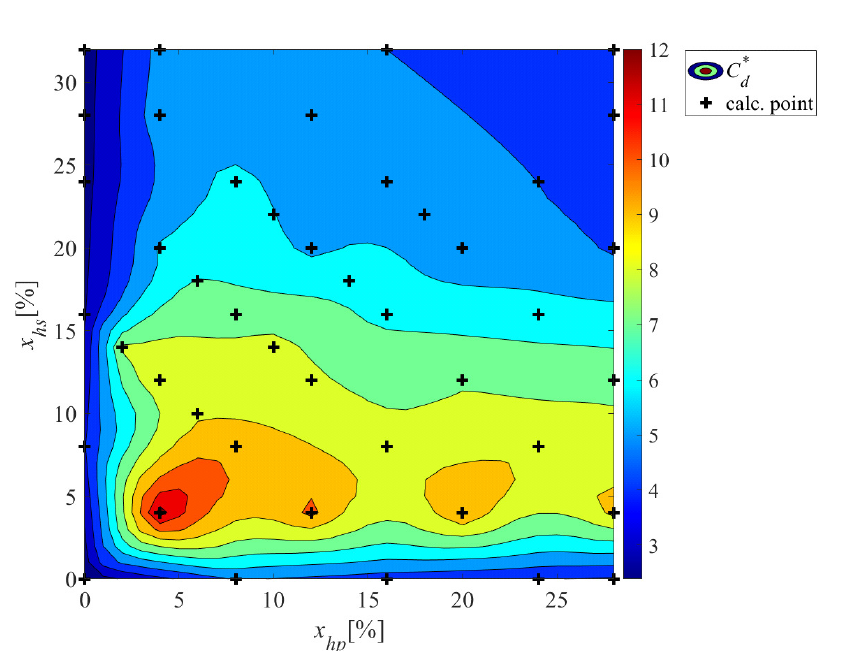
Figure 7. Drag coefficient change C ∗